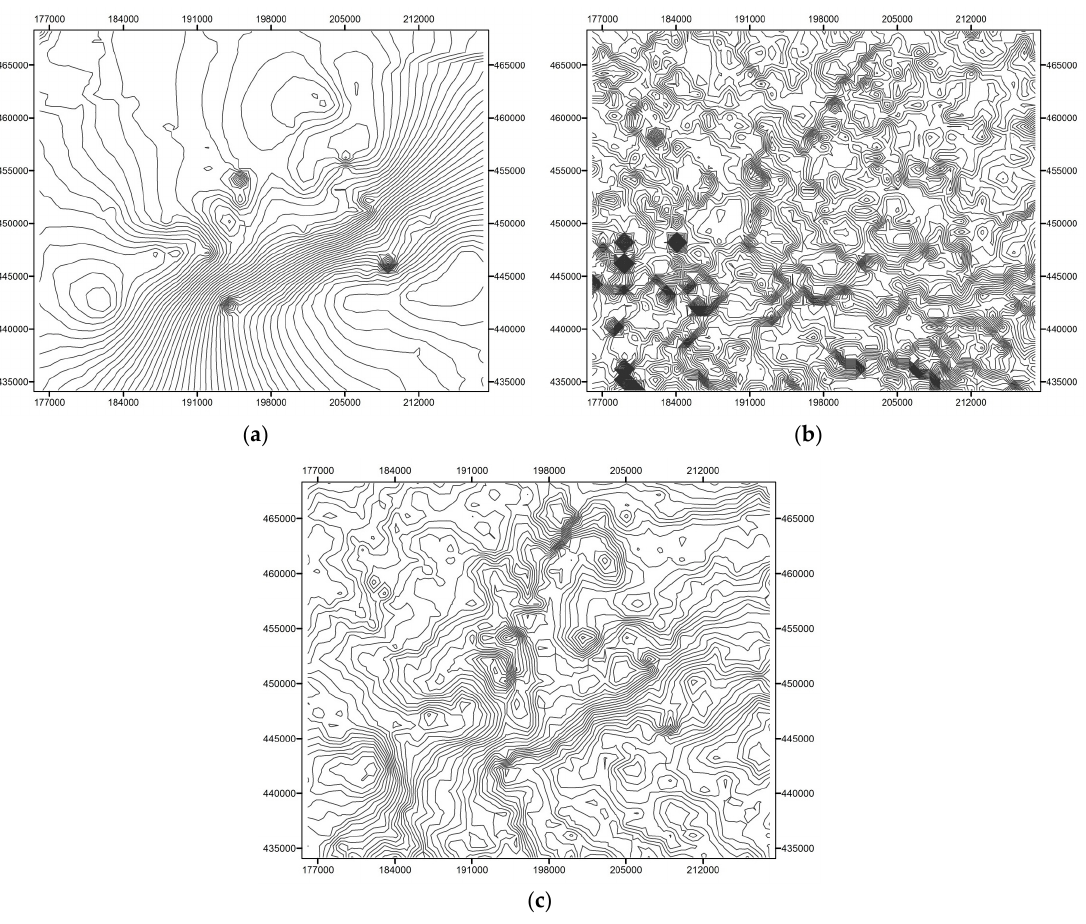
Figure 4. Normalized rainfall contours for 22 July 2013: ( a ) Rainfall contours derived from QPE1; ( b ) Rainfall contours derived from QPE2; ( c ) Rainfall contours derived from QPE3.